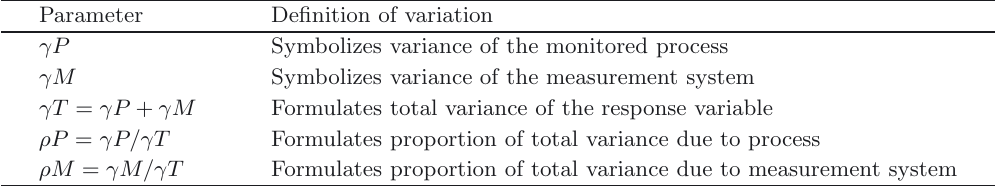
Table 2. Parameters, which describe the variation in the monitored process and the variation in the measurement system, in a Gauge R&R Study. Parameter Definition of variation γP Symbolizes variance of the monitored process γM Symbolizes variance of the measurement system γT = γP + γM Formulates total variance of the response variable ρP = γP/γT Formulates proportion of total variance due to process ρM =